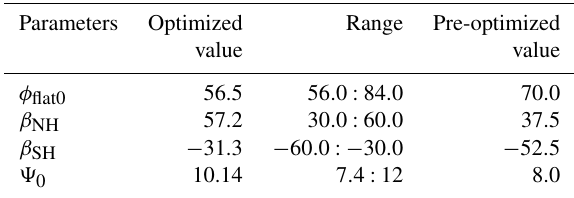
Table 2. Pre-optimized and optimized parameter sets and parameter ranges for optimization step